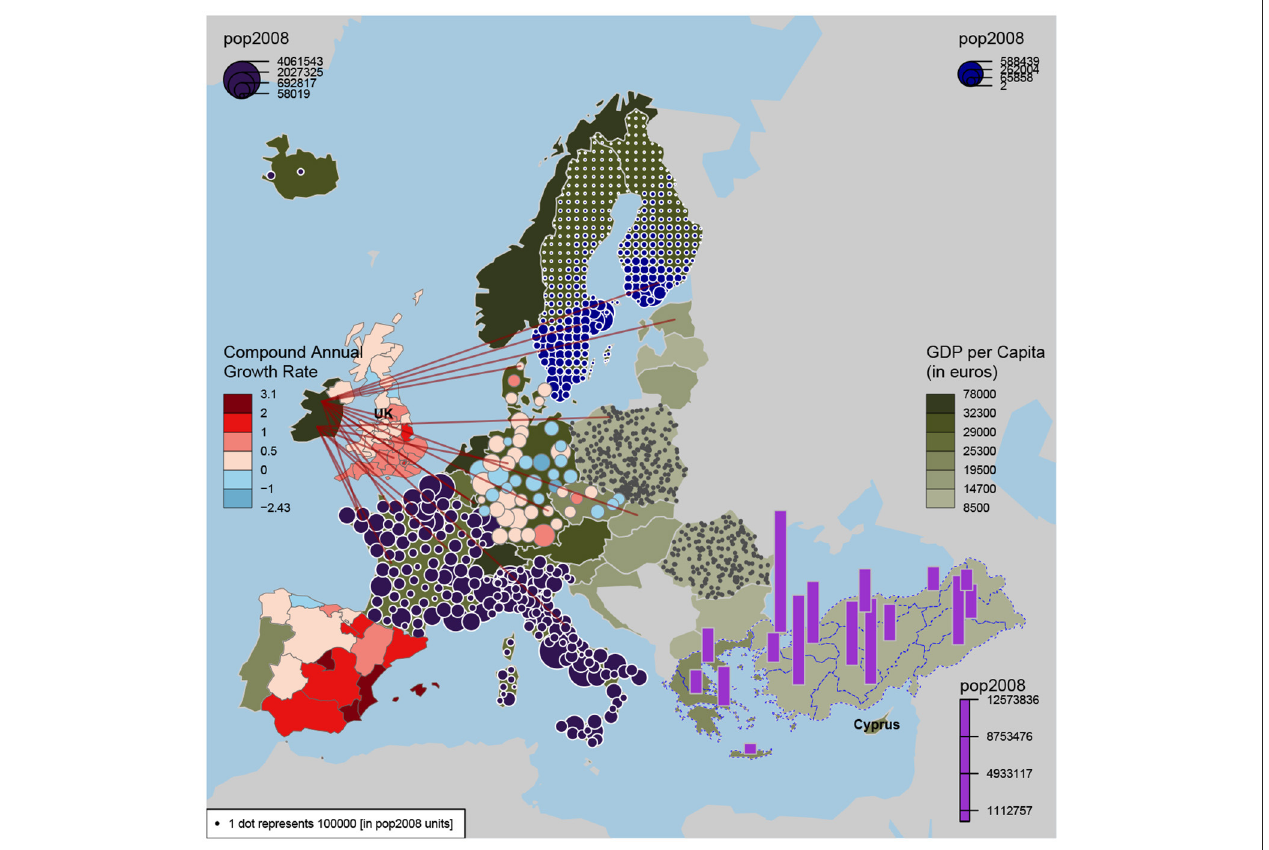
FIGURE 4 | Mapping economic networks with geographic locations by the cartography R